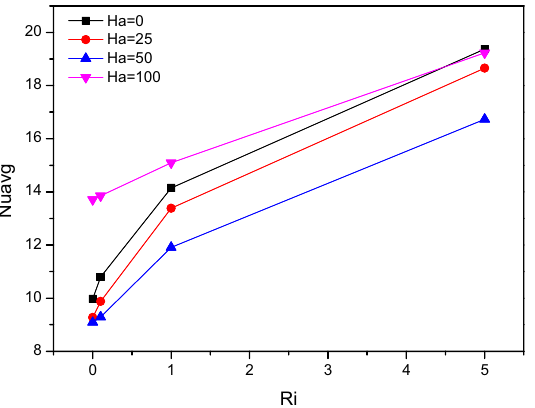
Figure 9. Variations of Nu avg with various Ri for Ha variations, Re = 1000 , ϕ = 0.02 .